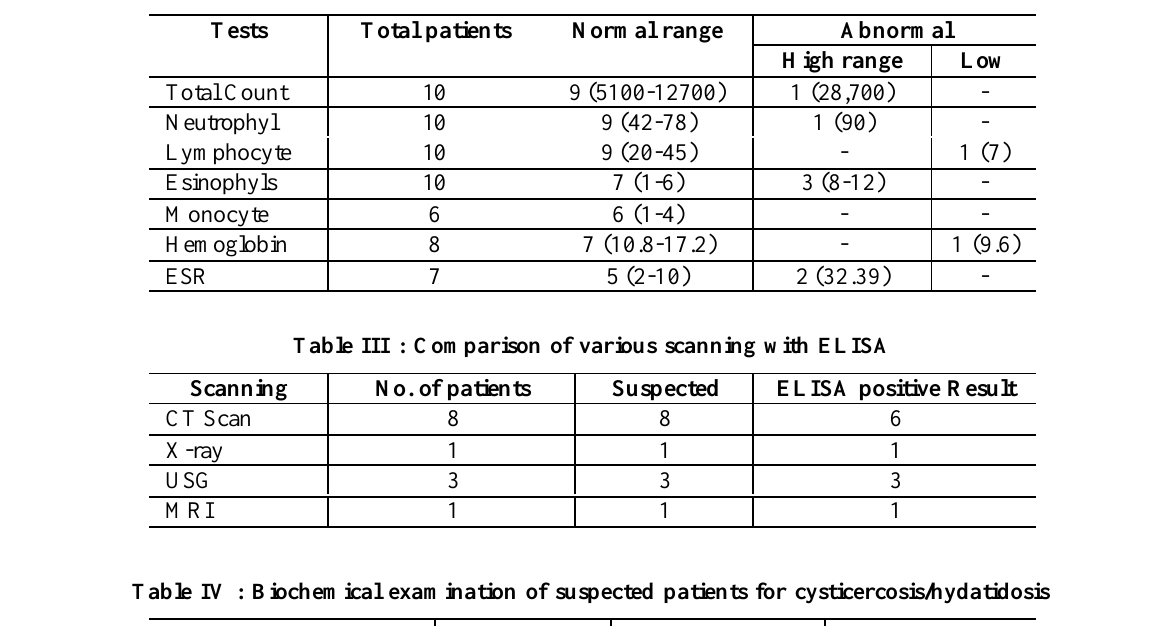
Table II : Blood examination results of suspected patients for cystic and alveolar hydatidosis